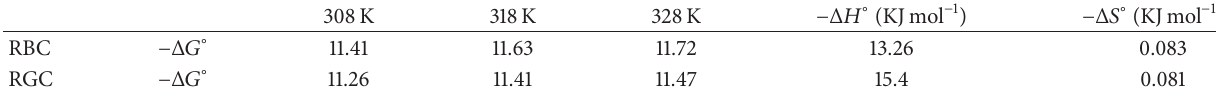
Table 5: Thermodynamic parameters.